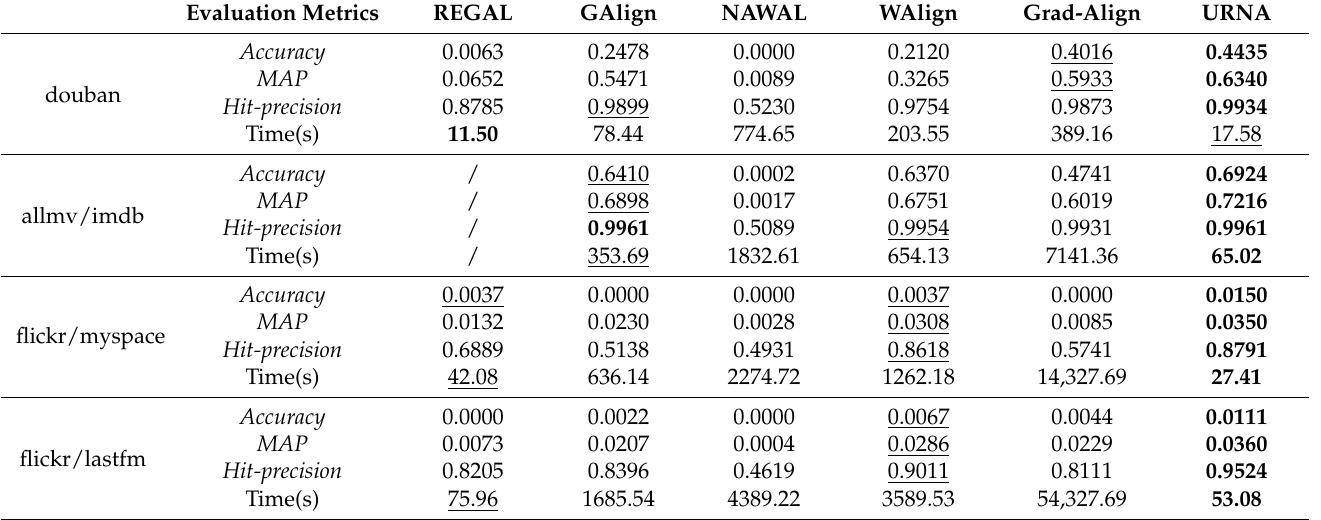
Table 2. Network alignment comparison of four real-world datasets. Here, the best and second best performers are highlighted by bold and underline,